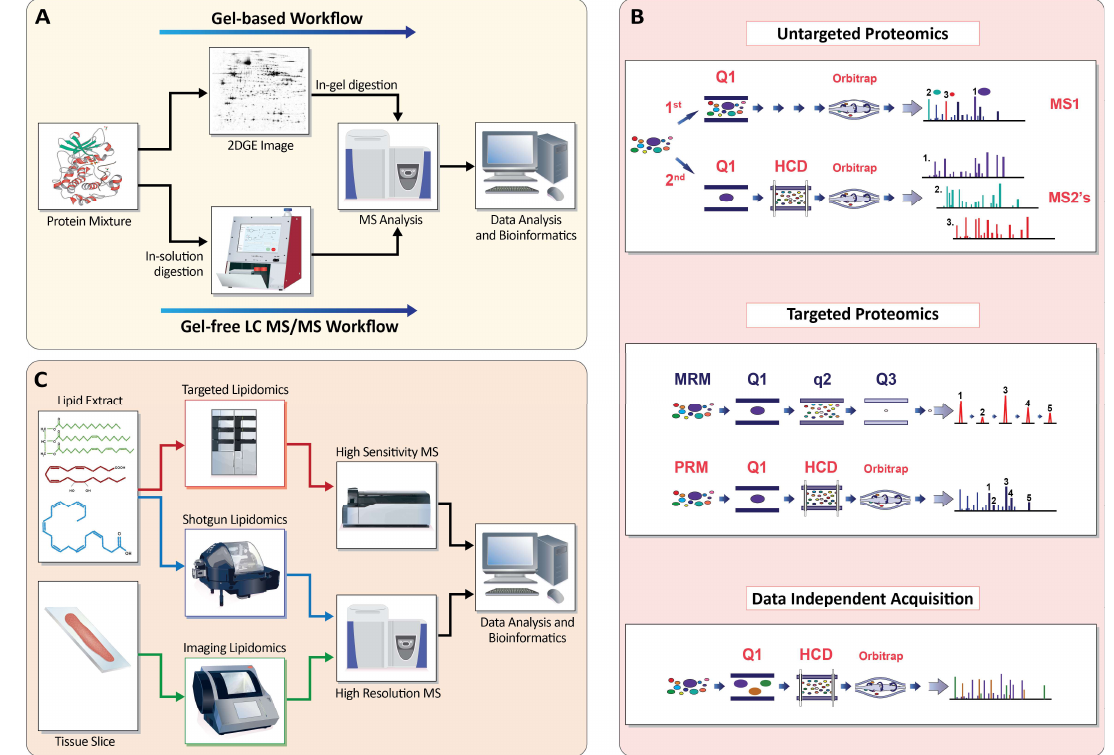
Figure 3. Schematic overview of the main proteomics and lipidomics technologies. ( A ) Gel-based and gel-free proteomics analysis workflows. In two-dimensional polyacrylamide gel electrophoresis (2D-PAGE), proteins are separated in two dimensions by molecular weight and isoelectric point. Proteins